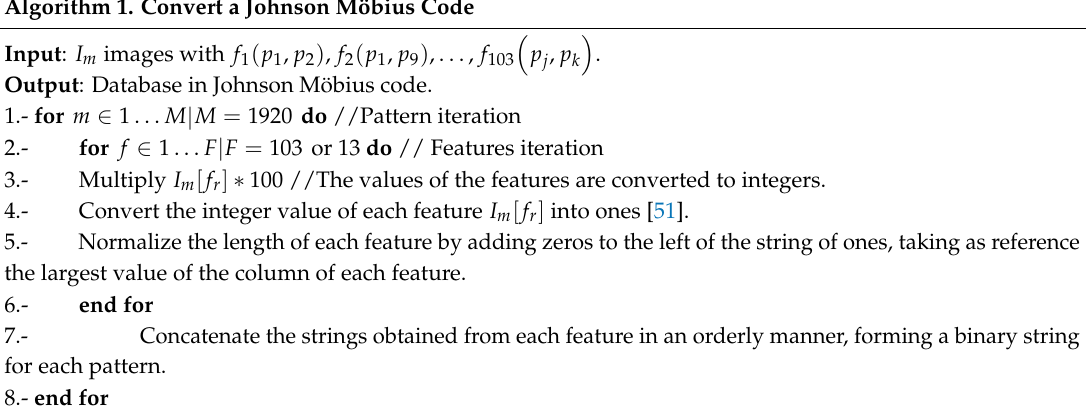
Algorithm 1. Convert a Johnson Möbius Code